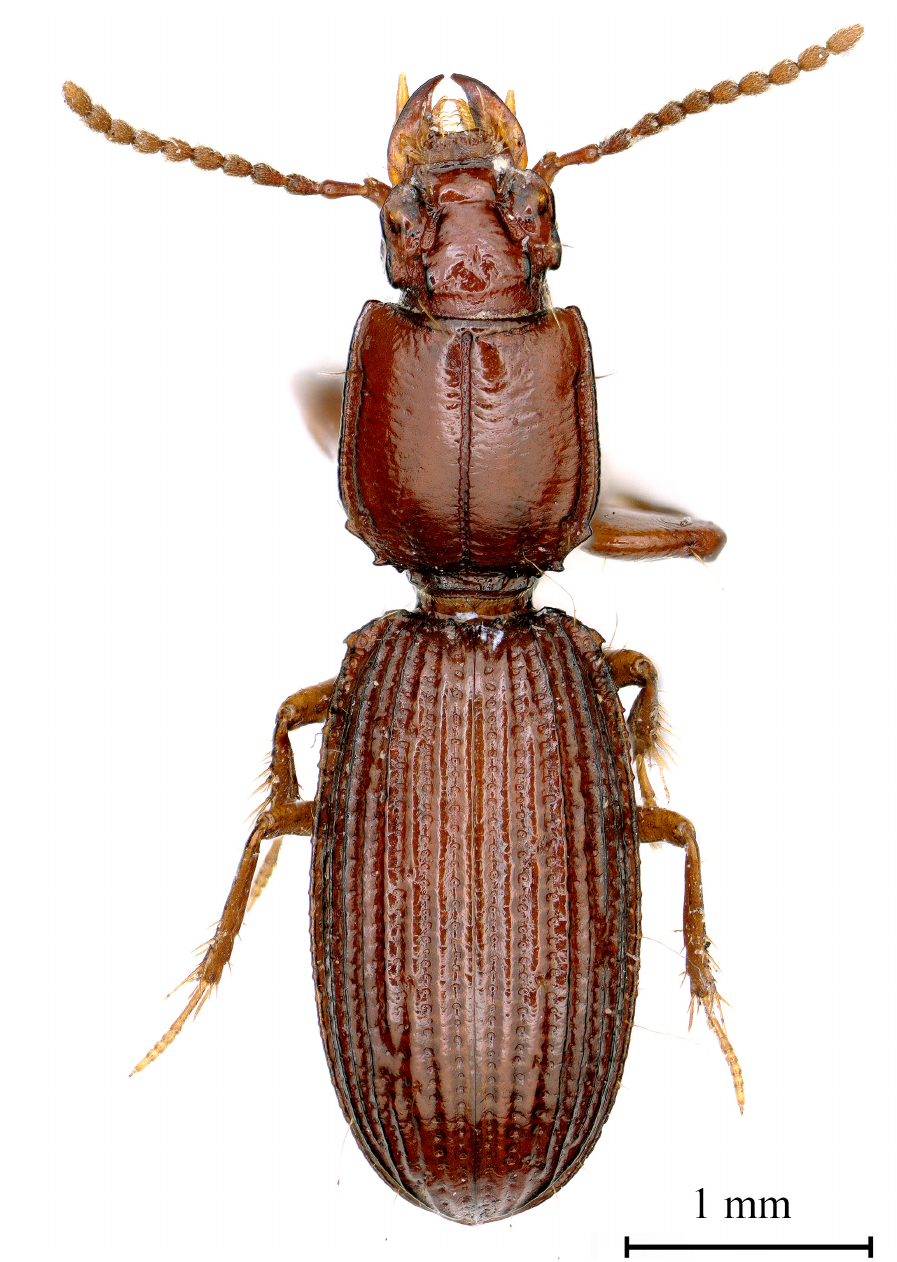
Fig. 2. Habitus of Guiodytes weii Huang & Faille sp. nov., holotype, ♂